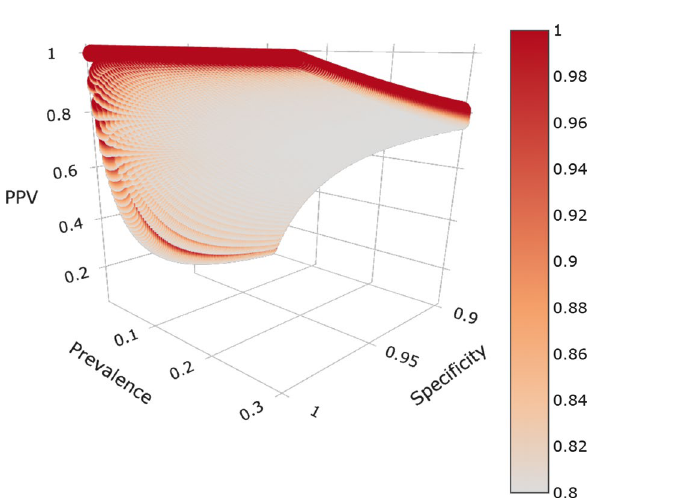
Figure 1. Plot of NPV by prevalence (0–0.3), specificity (0.9–1), and sensitivity (0.8–1). The bar on the right with sensitivity is denoted by color, with lighter colors denoting lower sensitivity and darker colors denoting higher sensitivity. All parameters are reported as decimals ranging from 0 to 1. NPV values exceeded 0.9 for all input parameters.